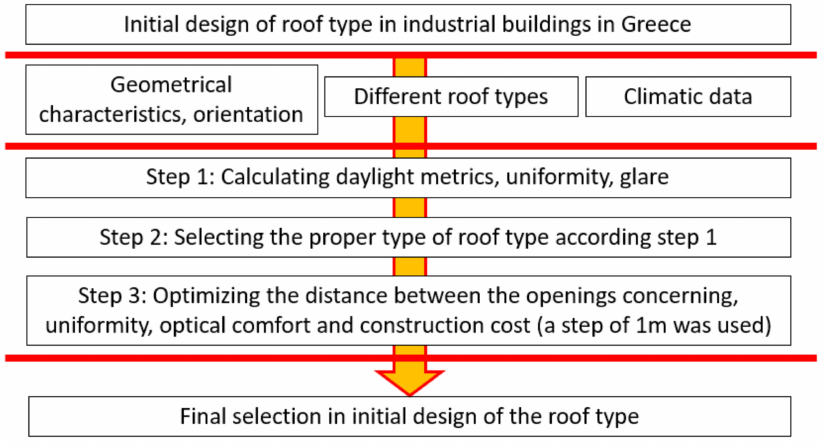
Figure 2. Dimensions of the industrial building (Length: 55 m, width: 20 m, height: 10 m).